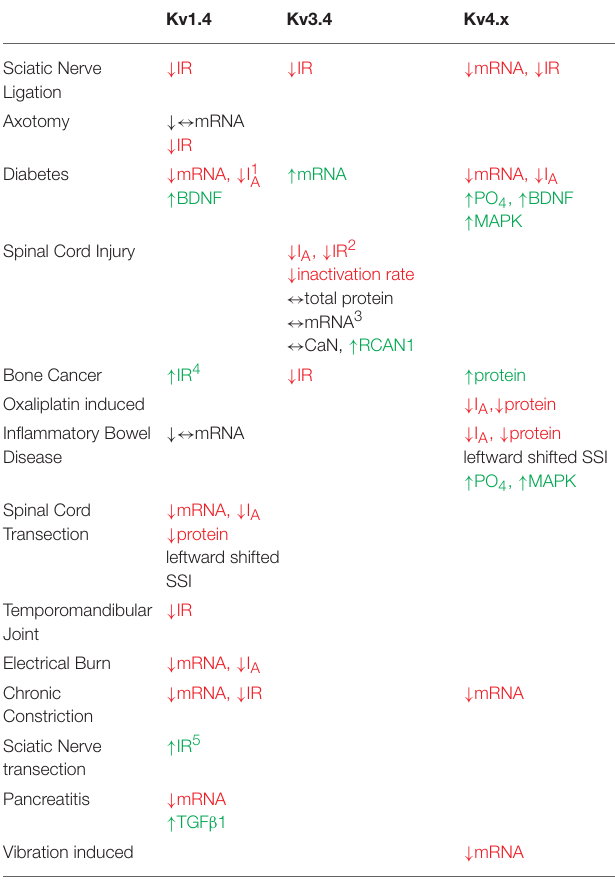
TABLE 2 | Pain model-induced changes in A-type Kv channel expression, function and modulation in DRG